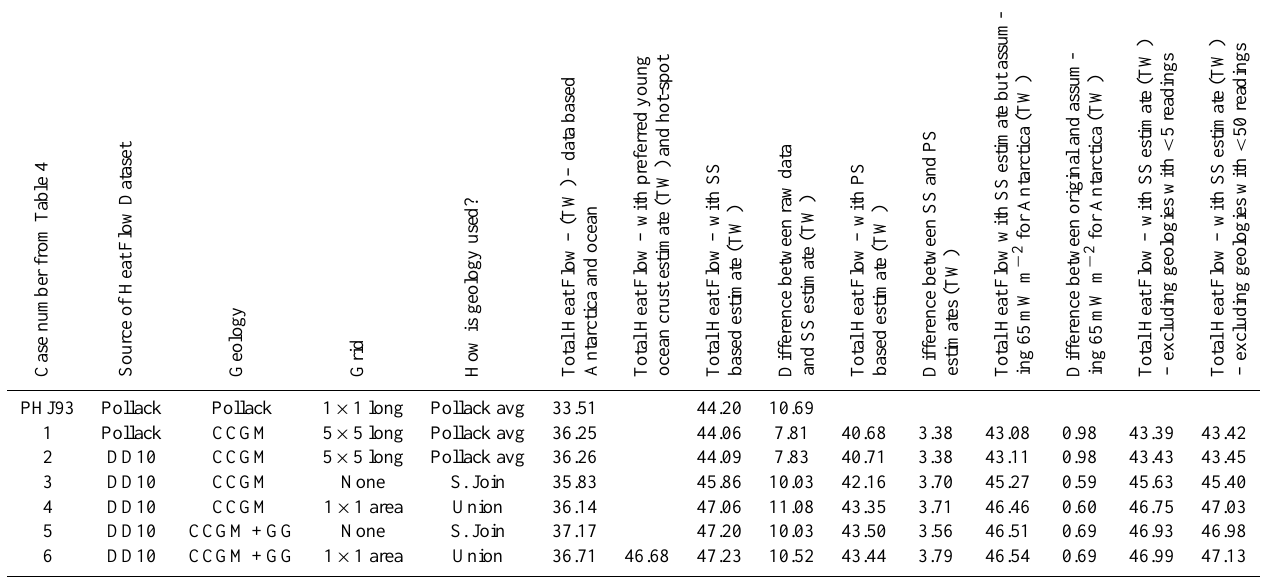
Table 5. The total global surface heat flux from the various analyses undertaken. Note that the first row of results is from Pollack et al. (1993). Pollack is used as an abbreviation for the heat flow data-set, the geology and the method of using geology, used in Pollack et al. (1993). SS – Stein and Stein (1992); PS – Parsons and Sclater (1977); S. Join – spatial join; 1 × 1 long – 1 degree by 1 degree equal longitude grid; 1 × 1 area – 1 degree by 1 degree equal area grid; CCGM – Commission Geology Map of World (2000); GG – Global GIS (2003); DD10 – the data-set presented in this paper. The original version was provided by Laske and Masters (pers. comm.) and DD10 has only minor changes. See text for further explanation of terms and abbreviations used in table.